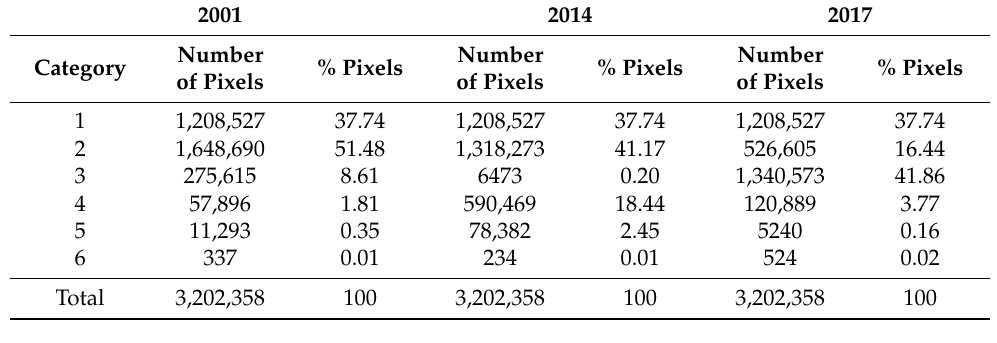
Table 1. Information on the unsupervised classification in PCI Geomatics for the years 2001, 2014, and 2017 in the ITT Oil Block of the Ecuadorian Amazon region.